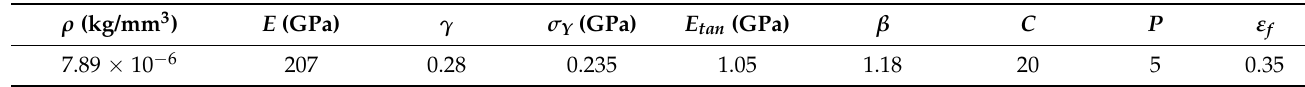
Table 2. Material parameters of the plastic kinematic